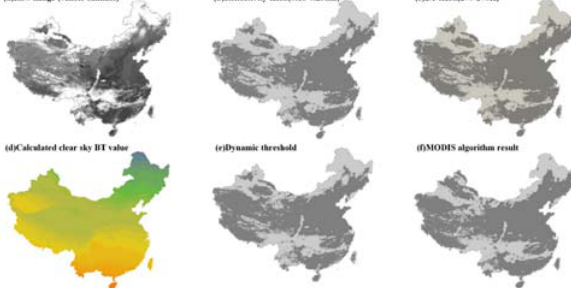
Figure 10. Result of accuracy assessment